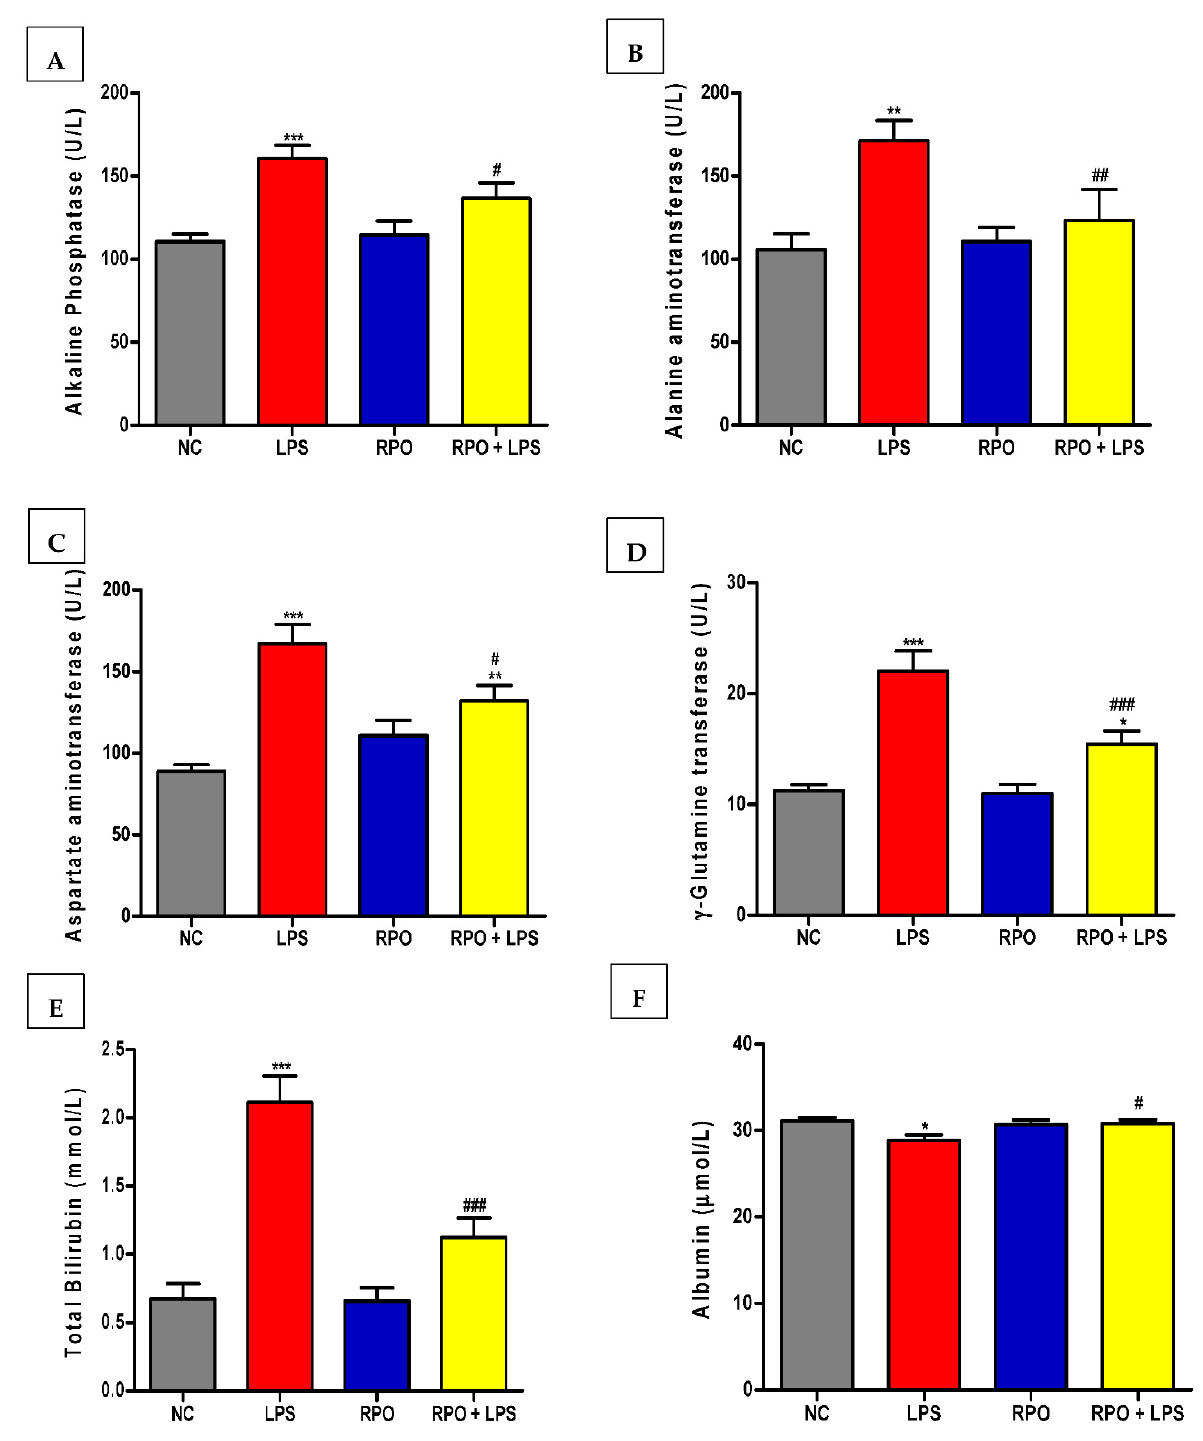
Figure 2. RPO prevents liver injury in LPS-induced rats. RPO ameliorated serum ( A ), alkaline phosphatase ( B ), alanine aminotransferase ( C ), aspartate aminotransferase ( D ), γ -glutamine transferase ( E ), total bilirubin and improved ( F ) albumin in rats injected with LPS. Data are mean ± SEM ( n = 8–10). * p < 0.05, ** p < 0.01 and *** p < 0.001 as significant difference compared with NC. # p < 0.05, ## p < 0.01 and ### p < 0.001 as significant difference compared with LPS. NC (normal control group), LPS (lipopolysaccharide), RPO (red palm oil).